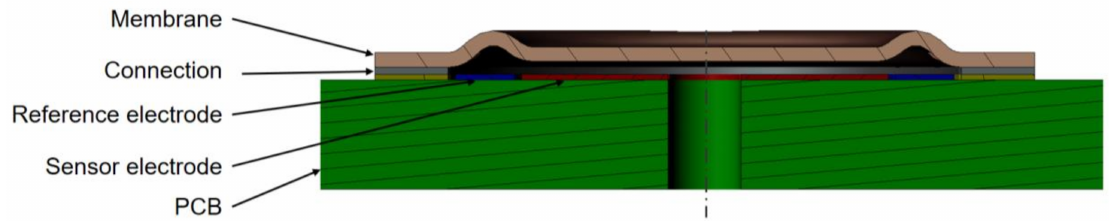
Figure 2. Functional principle of the pressure sensor (sketch, cross section).